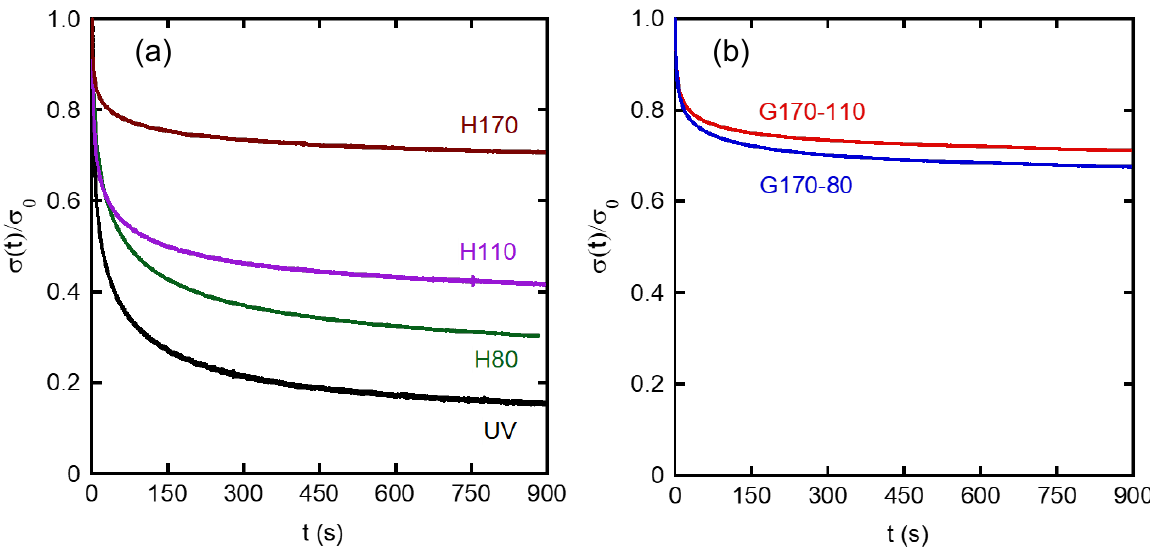
Figure 4. Relaxation curves of normalized stress, i.e., stress σ ( t ) divided by that at the cessation of stretching at ε = 1 σ 0 for ( a ) homogenous samples and ( b ) graded samples.